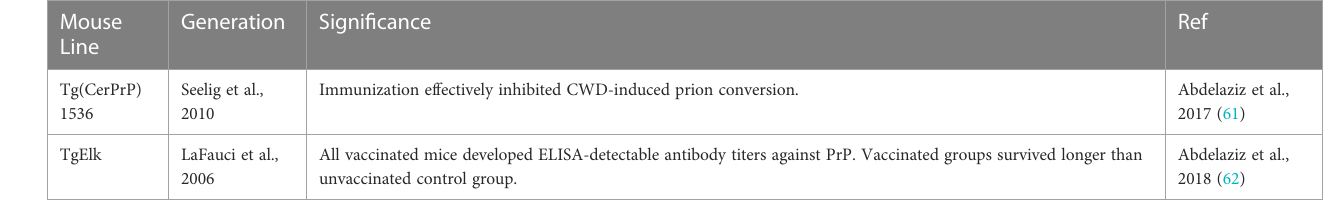
TABLE 11 Mouse models used for investigating CWD therapies. Mouse Line